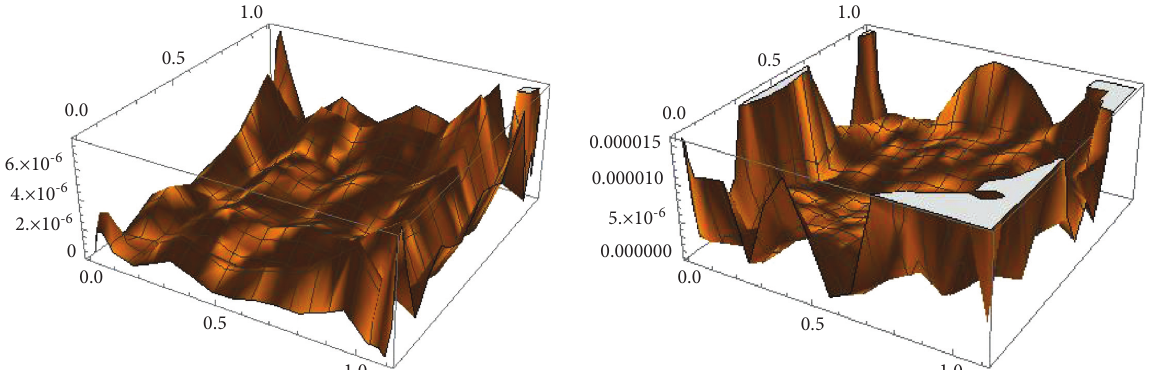
Figure 6: The plot 3D errors for both mesh and meshless